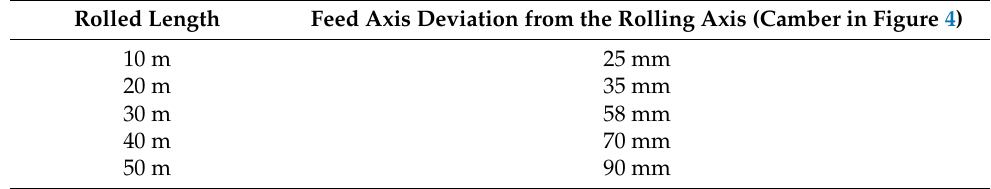
Table 1. Permissible camber for Mill 5000.